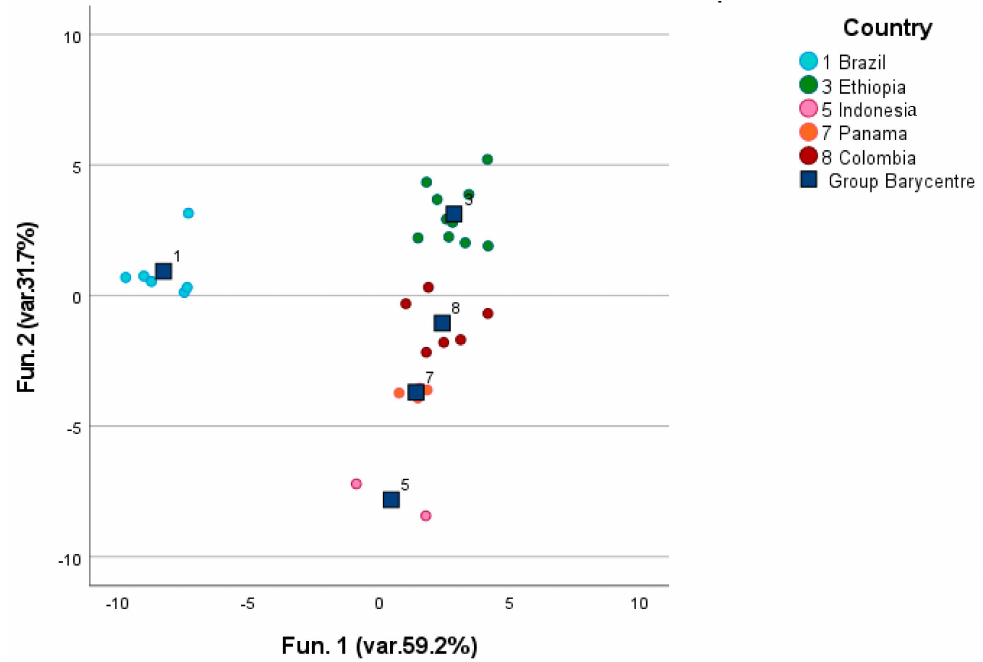
Figure 8. Discrimination of the countries of origin in the dark-roasted coffee subcluster. The discriminant molecules were 4,6-dimethylpyrimidine; 5-methyl-2-furfuraldhyde; 1-methyl-2-formylpyrrole; 2-furfurylpropan-1-one; benzene-acetaldehyde; 2,5-dimethyl-4- hydroxyfuran-1-one; and